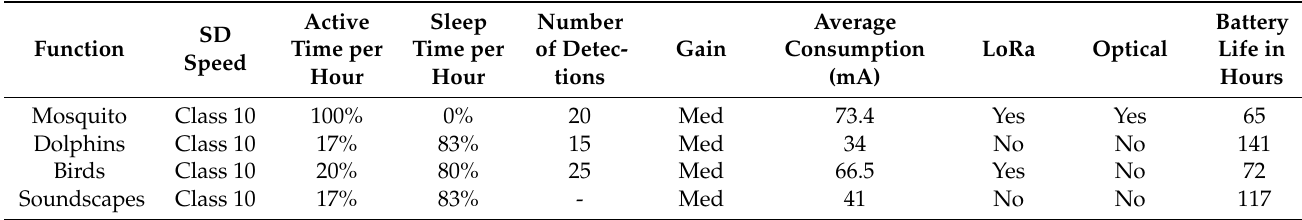
Table 7. Simulation of power durability